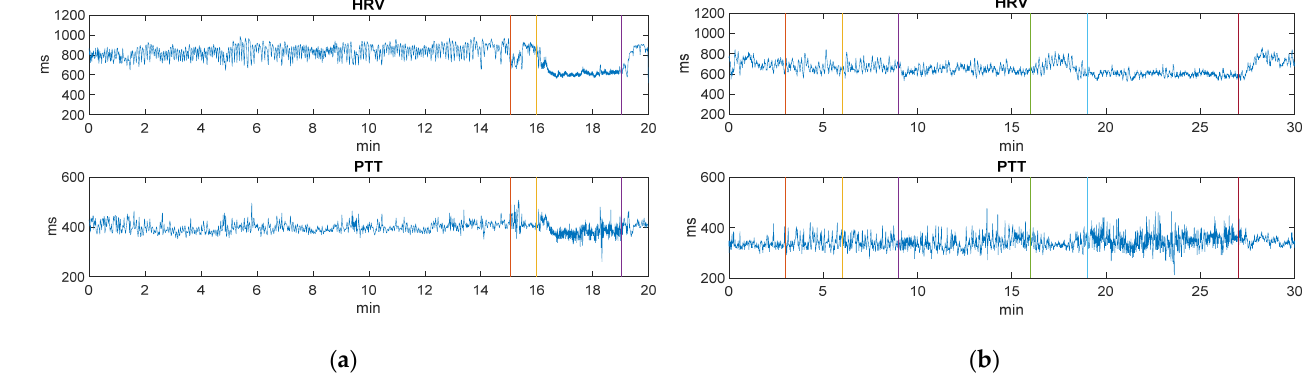
Figure 19. ( a ) Variation in milliseconds of HRV and PTT parameters in static validation. ( b ) Variation in milliseconds of HRV and PTT parameters in ambulatory validation. The vertical colored lines separate the periods of the different activities developed during the experimentation.